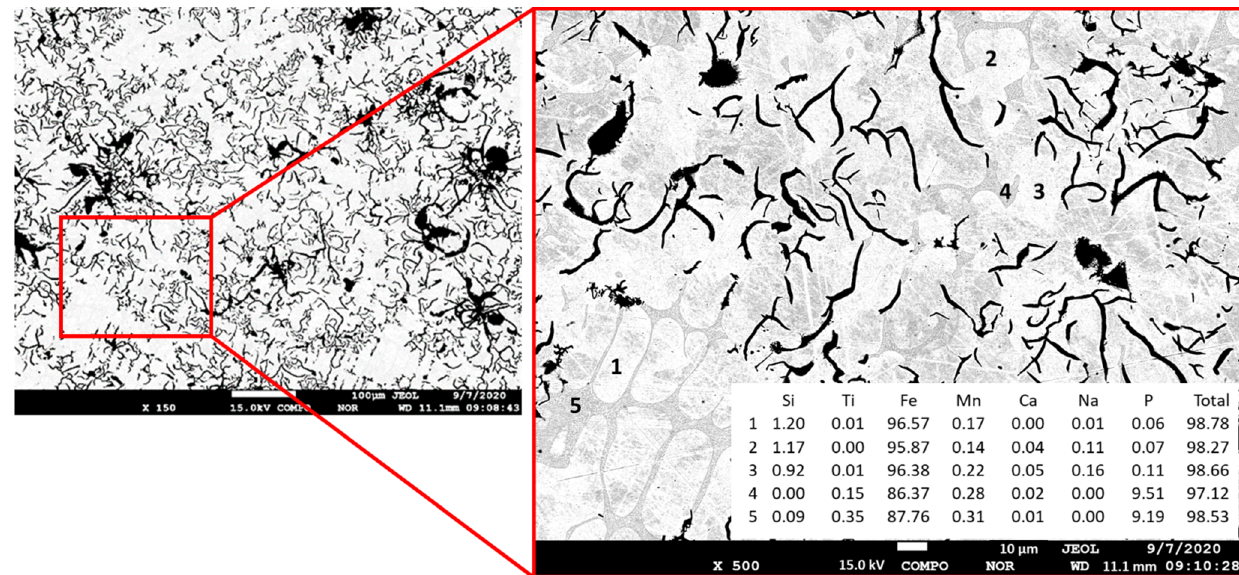
Figure 4. Example of large metal accumulation produced after reducing concentrate R2/l with 10% CaO addition. EPMA data on metal concentrations from points 1–5 expressed in wt%.